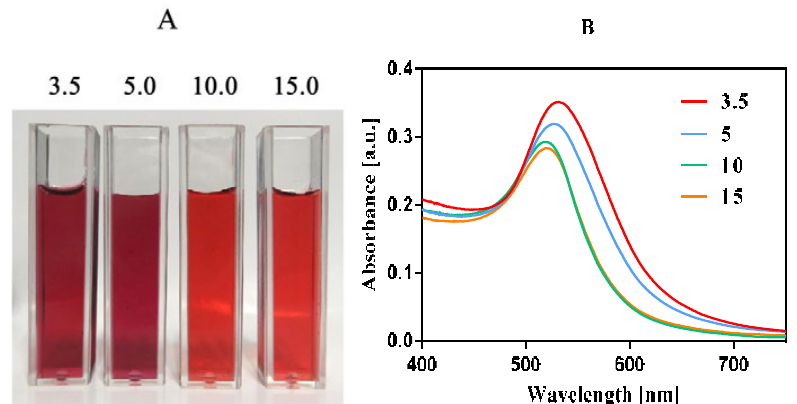
Fig.1. Image (A) and UV-vis spectra (B) of gold nanoparticles samples that synthesized via ‘reversed Turkevich’ method at various Sodium citrate/HAuCl 4 molar ratios: 3.5, 5.0, 10.0, and 15.0.